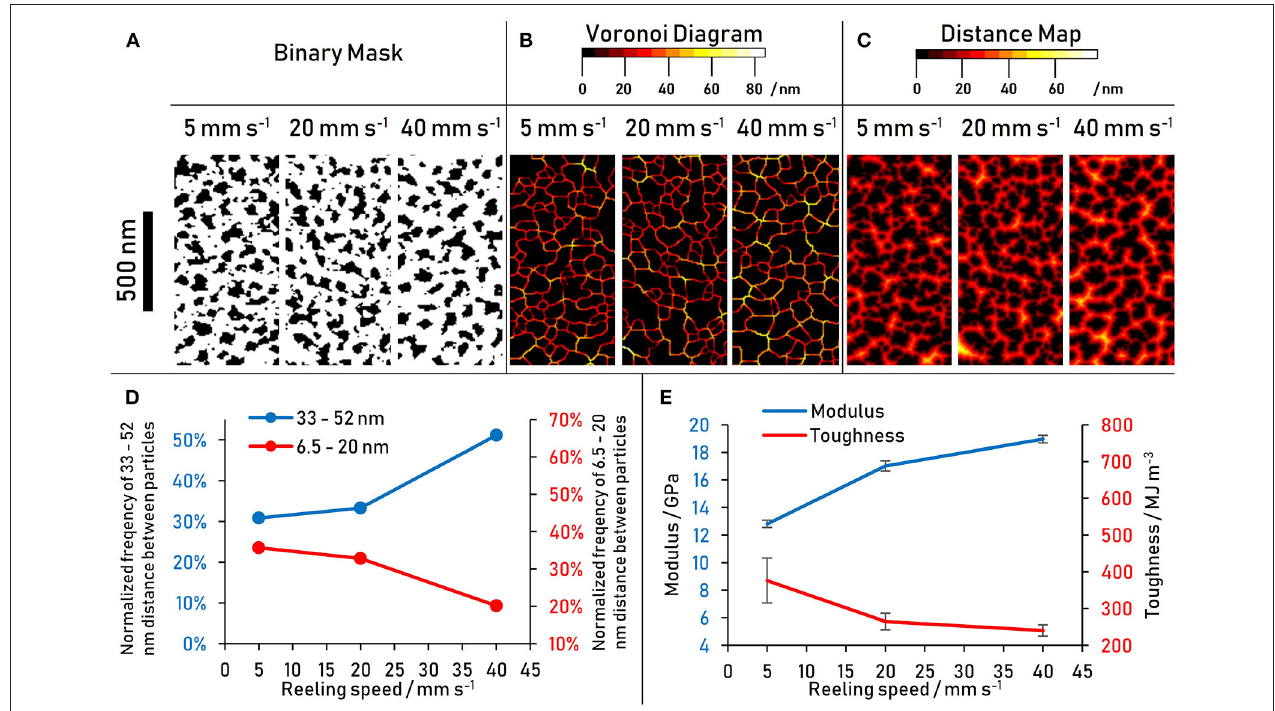
FIGURE 6 | (A–C) Particle analysis of nanostructure in 10min plasma treated spider dragline silk performed on hyperspectral images shown in Figure 5 . The images show a sample of a total sample area of 4 µ m 2 . (D) Frequency of larger (33–52nm) and smaller (6.5–20nm) nanostructure Voronoi distances with reeling speed (E) Modulus and toughness with reeling speed of the same spider silk